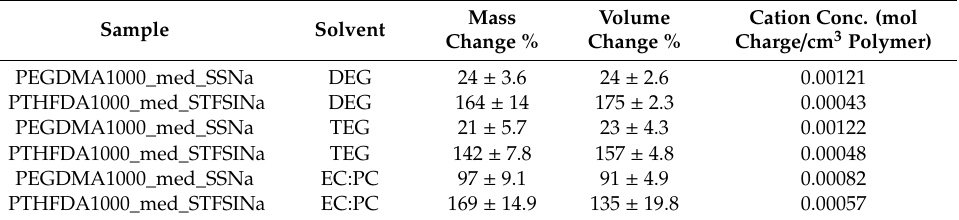
Table 5. Swelling mass and volume % change for various